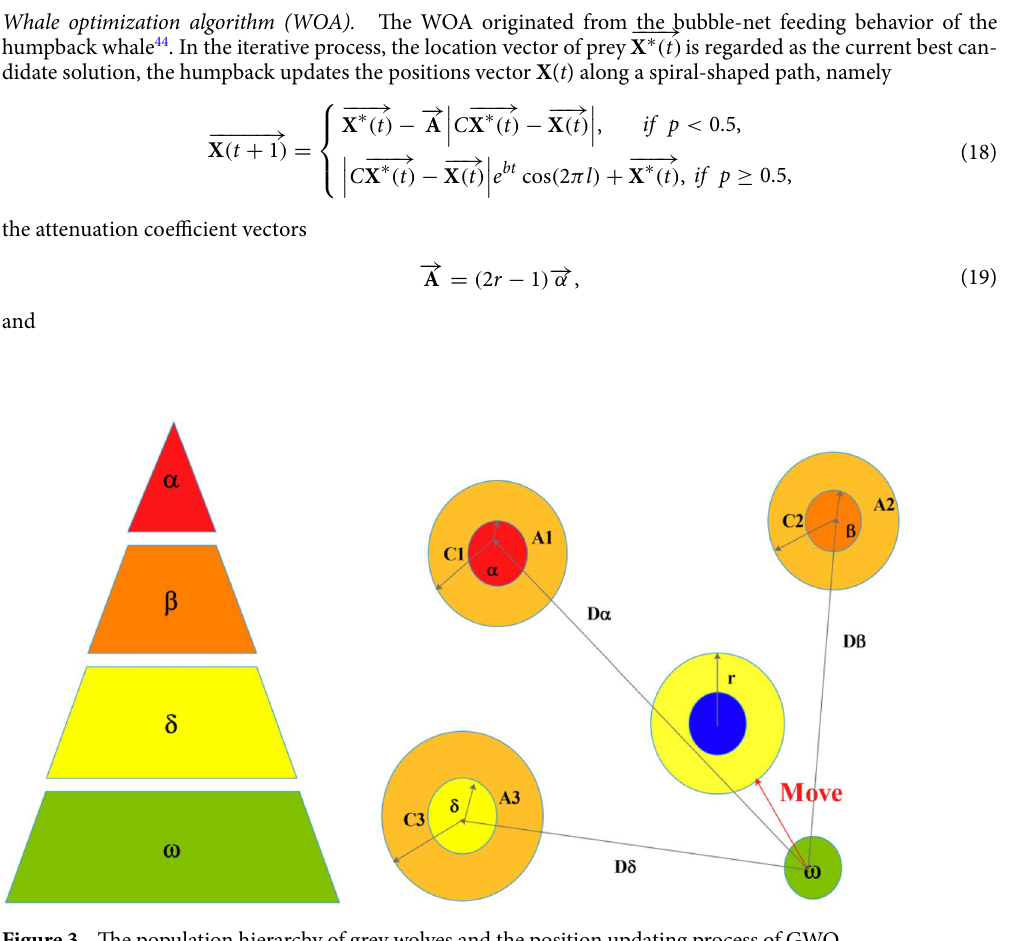
Figure 3. The population hierarchy of grey wolves and the position updating process of